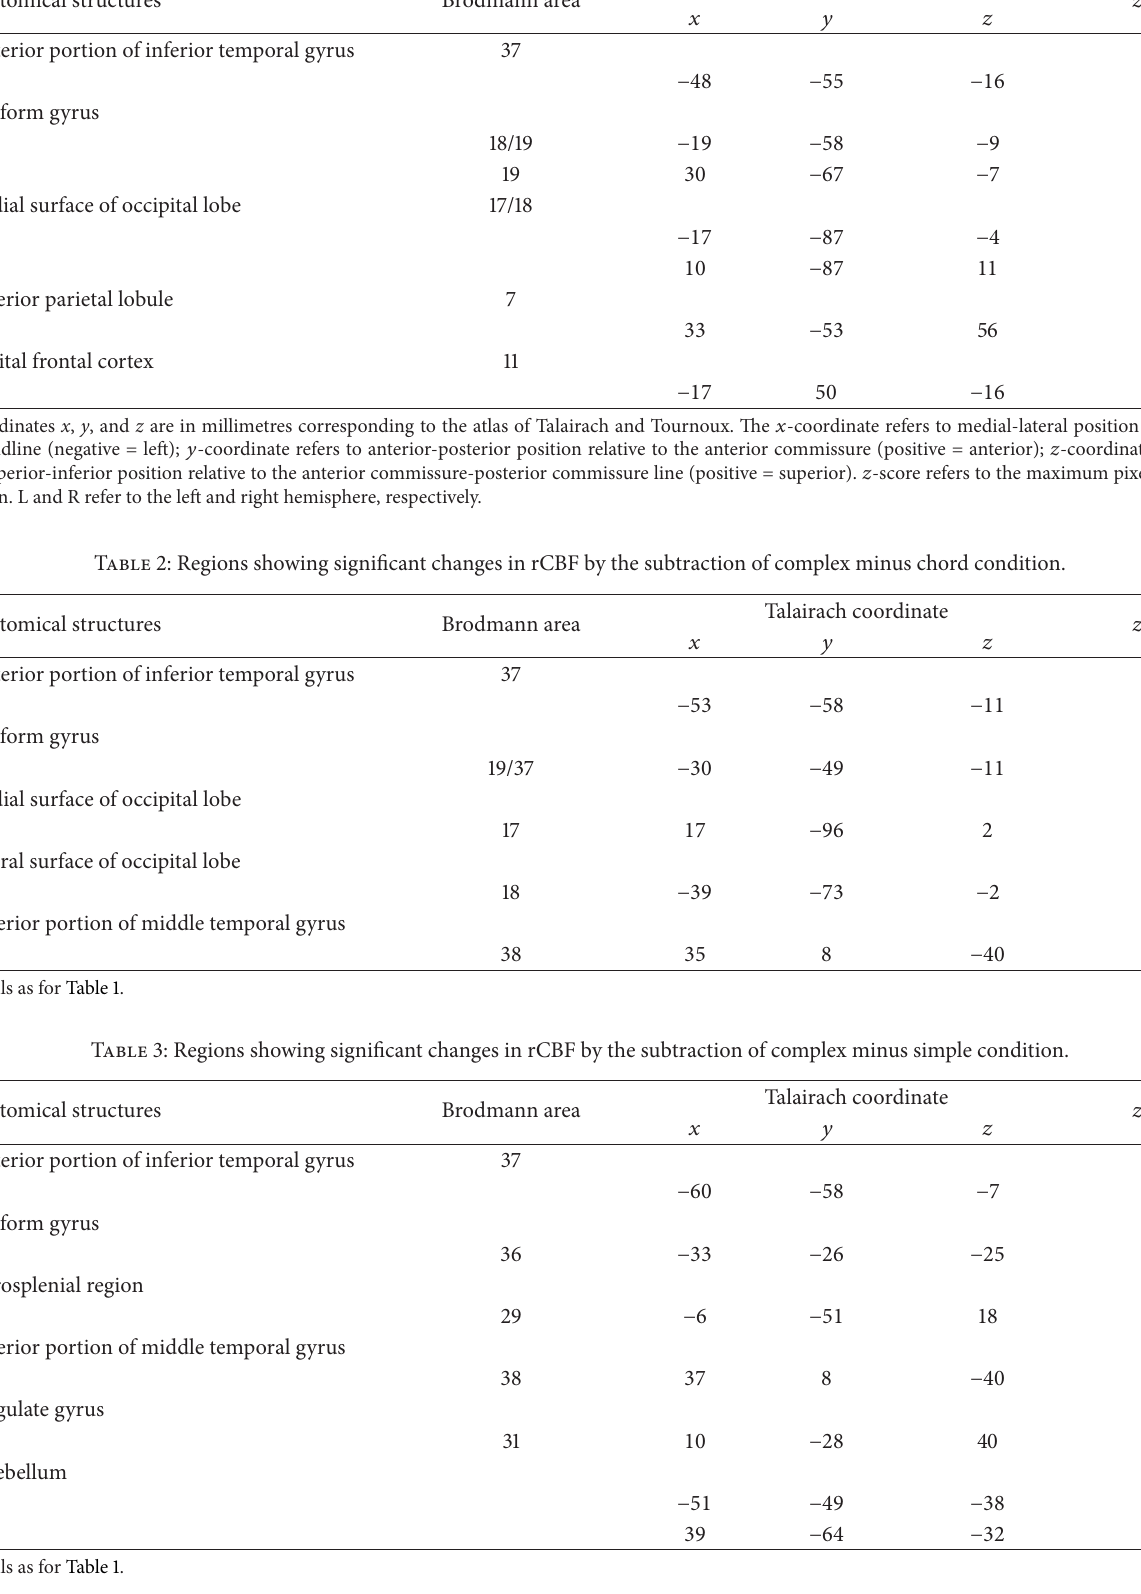
Table 1: Regions showing significant changes in rCBF by the subtraction of simple minus chord condition. Anatomical structures